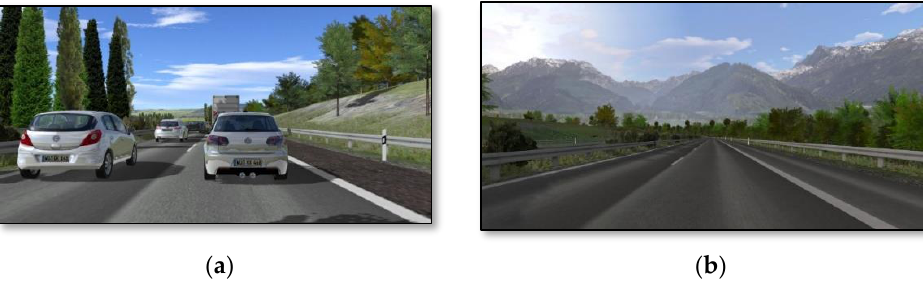
Figure 3. Illustration of the traffic scenario on a highway in slow-moving traffic: ( a ) The ego vehicle behaved as in slow-moving traffic; ( b ) However, the participants could not see the surrounding traffic.